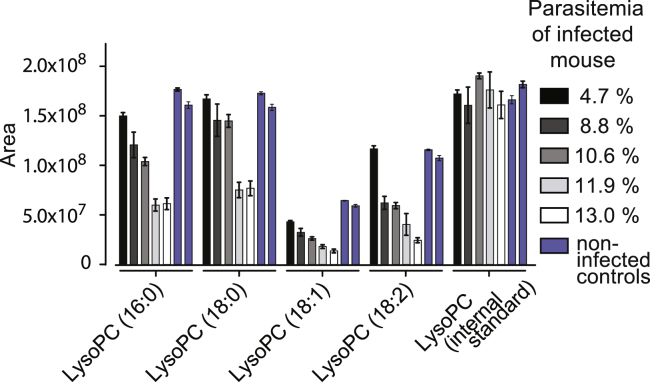
Related to Figure 6LysoPC drops in response to parasite infection. Serum LysoPC levels were quantified in 5 mice infected with P. berghei and in 2 non-infected controls. LysoPC concentrations decrease in a parasitemia-dependent manner. Bars quantify area under the curve. Shown are standard errors of the means from 3 technical replicates.